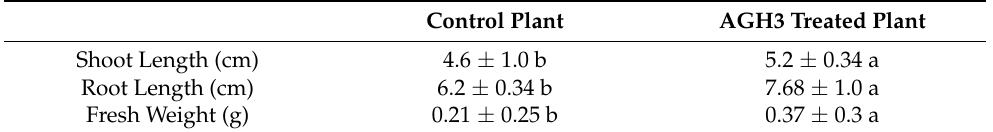
Table 3. Bioassay assessment for growth promotion activity of the competent isolate AGH3 in Waito-C rice. Different letters in the column show that values are significantly different ( p < 0.05) from each other as evaluated from the DMRT test.